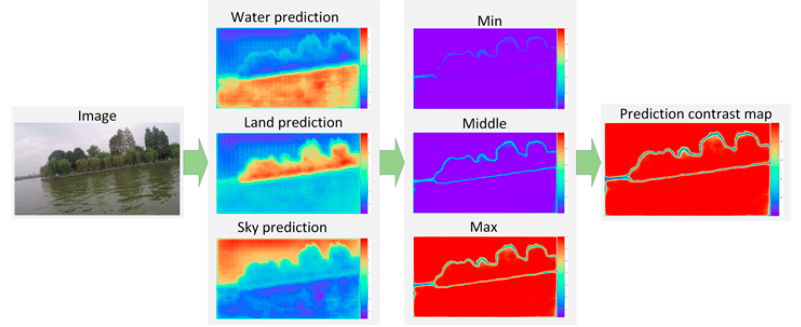
Figure 2. Analysis of prediction results in different regions.